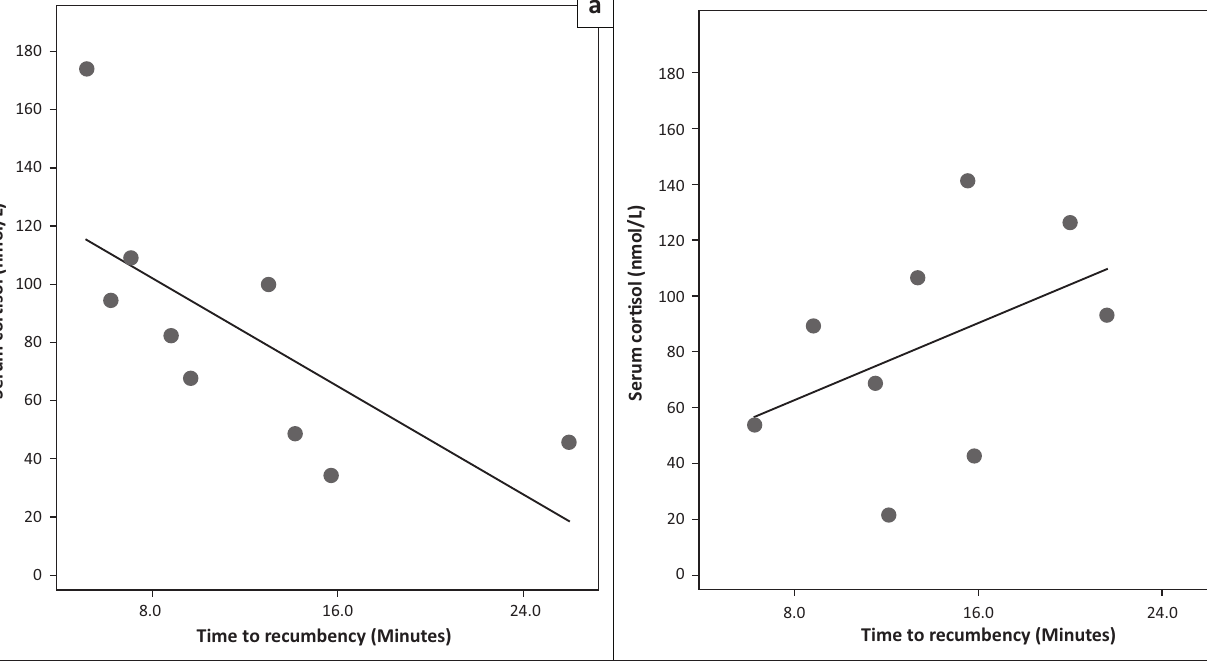
FIGURE 1: Scatter plots with general linear modelling demonstrating the significant difference ( p = 0.023) of cortisol concentration (nmol/L) of impala ( Aepyceros melampus ) versus the time to recumbency (minutes) between (a) thiafentanil-medetomidine and (b)